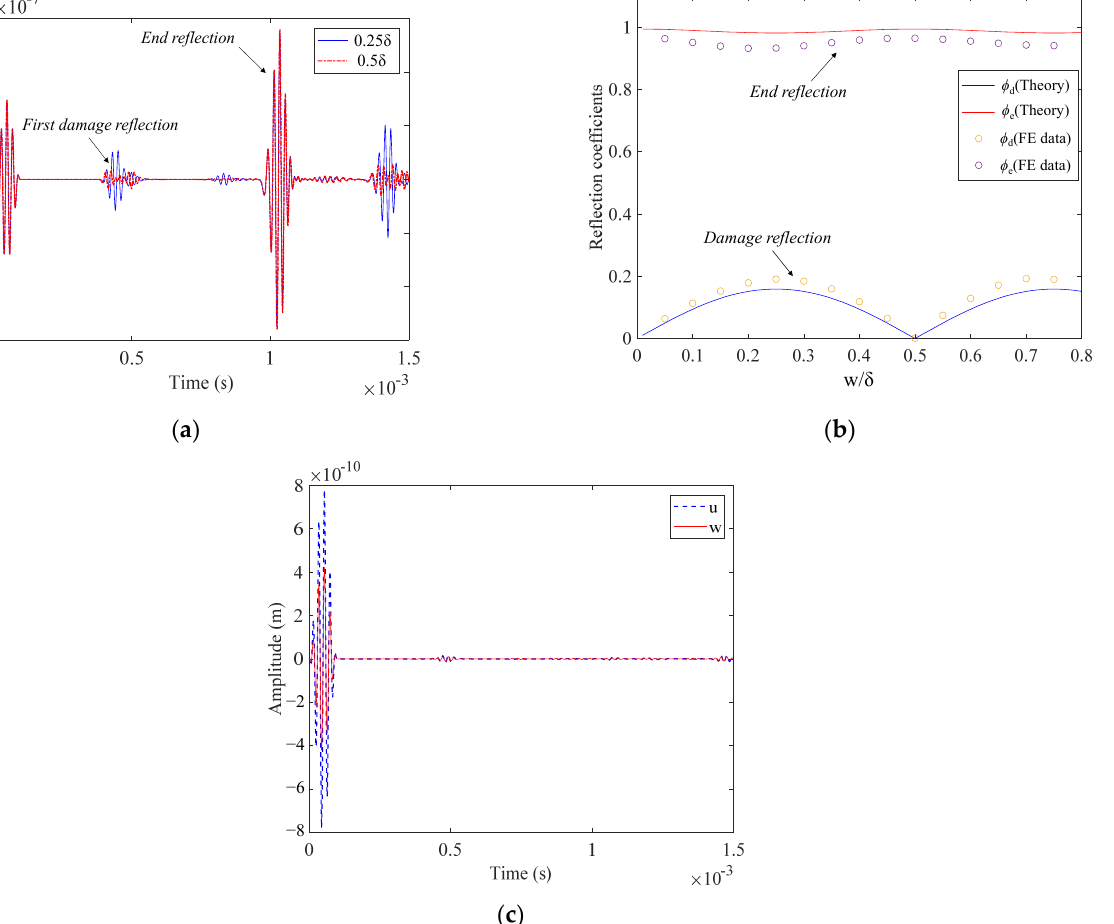
Figure A2. Influence of defect width on torsional wave reflections: ( a ) time-domain signals of torsional wave components considering different widths of defects; ( b ) reflection coefficients from the defect and end in the theoretical analyses and finite element simulations; ( c ) time-domain signals of mode conversion-induced wave components for the 0.25 δ -wide defect case.